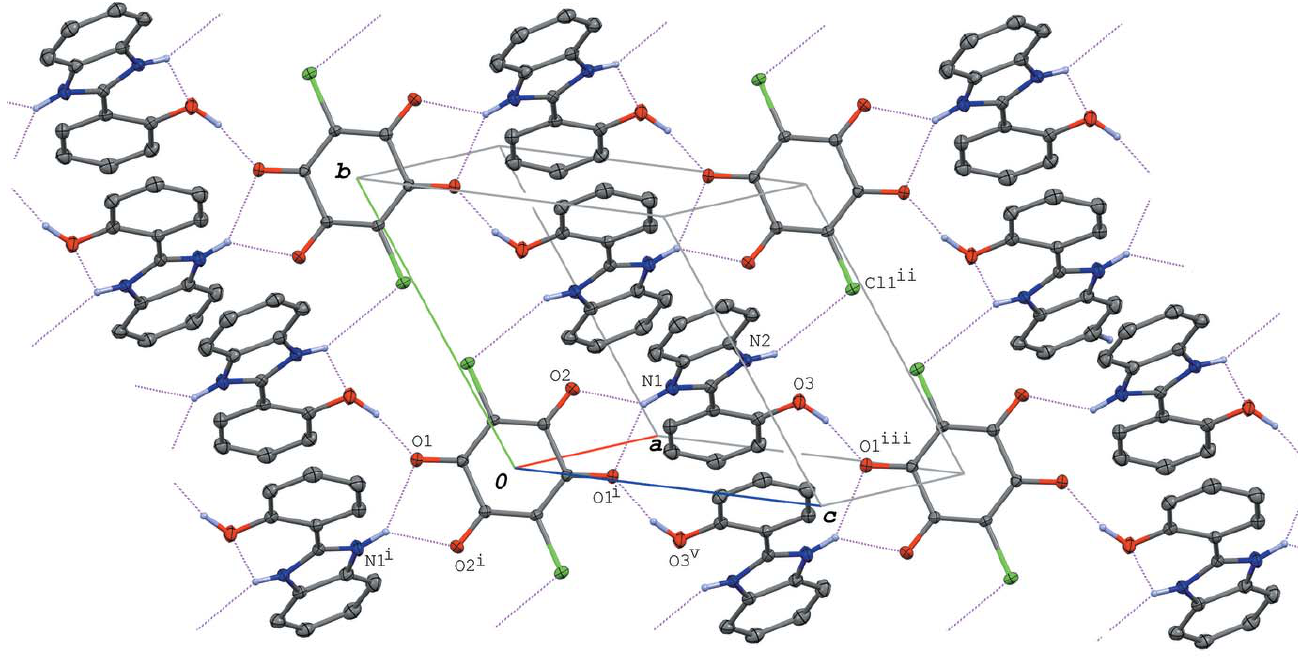
Figure 2 A packing diagram of the title compound, showing the hydrogen-bonded layer structure formed via the N—H (cid:2)(cid:2)(cid:2) O, O—H (cid:2)(cid:2)(cid:2) O and N—H (cid:2)(cid:2)(cid:2) Cl hydrogen bonds (magenta dotted lines). H atoms not involved in the hydrogen bonds are omitted for clarity. [Symmetry codes: (i) (cid:3) x , (cid:3) y , (cid:3) z ; (ii) (cid:3) x + 1, (cid:3) y + 1, (cid:3) z + 1; (iii) x + 1, y , z + 1; (v) (cid:3) x + 1, (cid:3) y , (cid:3) z + 1.]